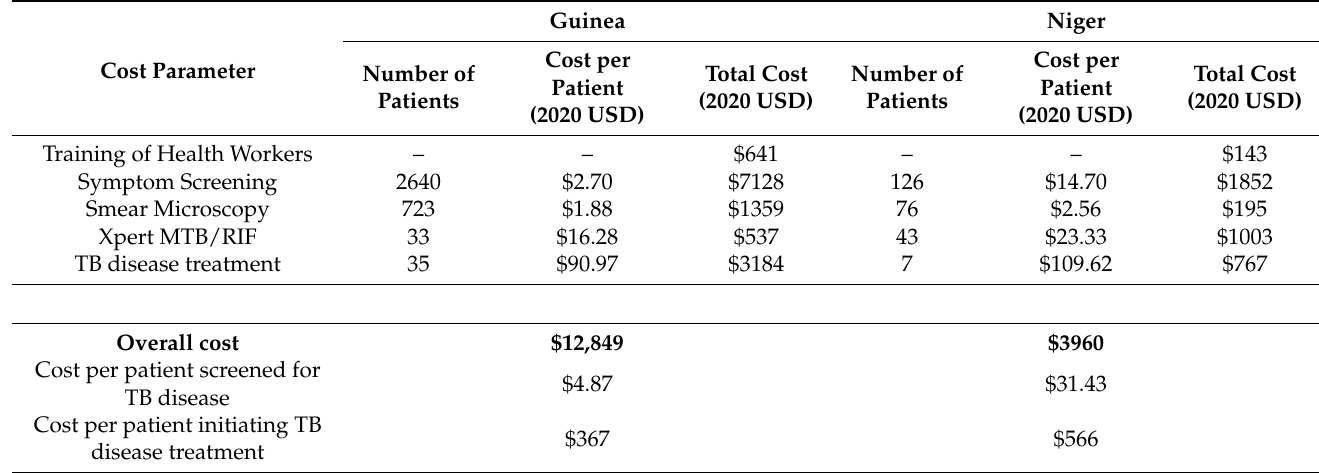
Table 3. Cost assessment of TB screening among presumed and/or recovered individuals in Guinea and